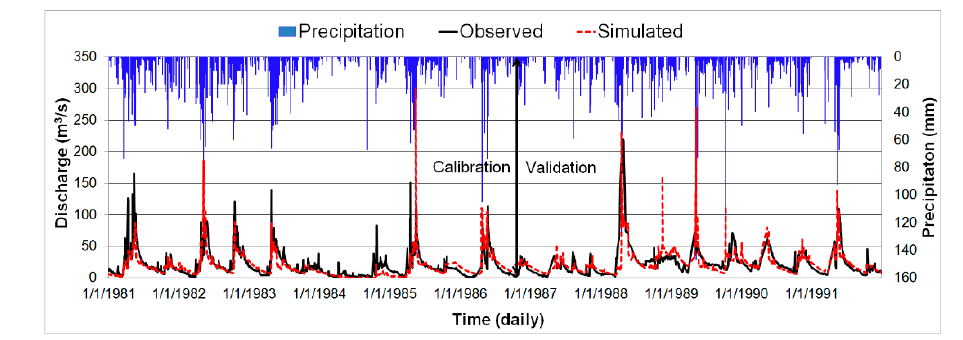
Water 2020 , 12 , x FOR PEER REVIEW Figure 5. SWAT model calibration and validation. Figure 5. SWAT model calibration and validation. Table 9. SWAT model calibration objective functions.